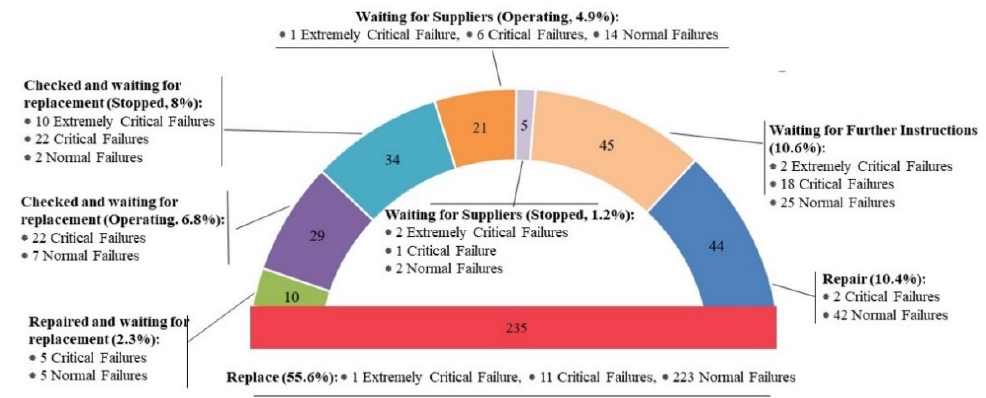
Figure 7. Maintenance measures.